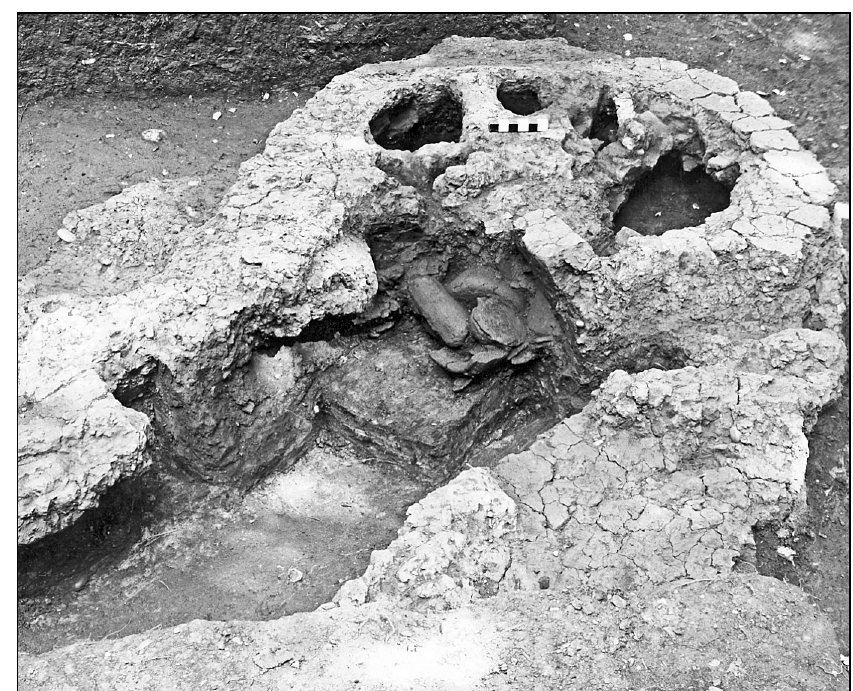
Figure 4 Kiln 4 under excavation at Highgate Wood in 1969, showing the remains of the flue (lower left) and the firing chamber (centre and upper right), with its central ped- estal (in front of the scale bar) and fire bars (between the holes beyond the scale bar) that supported the platform on which the pots were placed for firing (scale bar 6 inches).